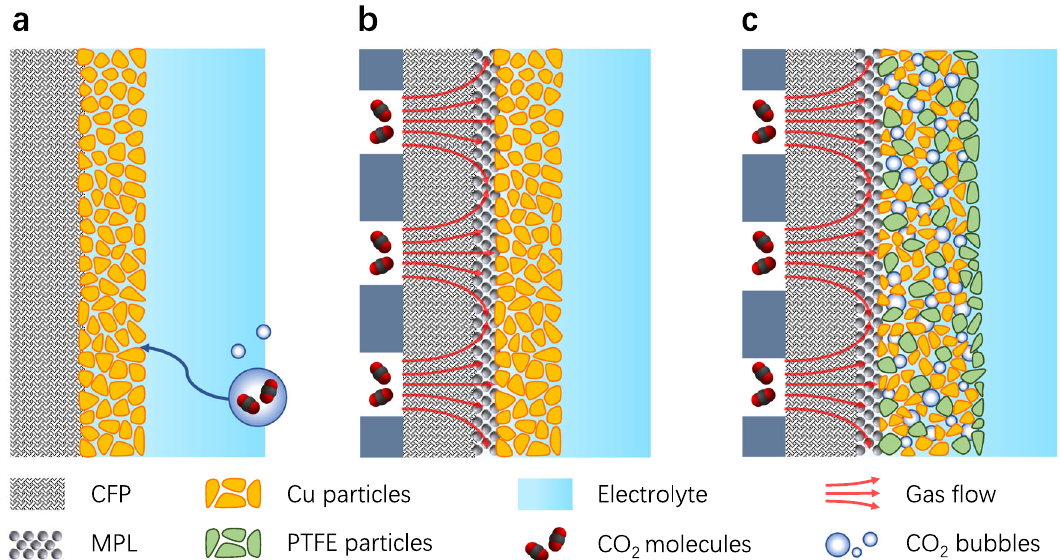
Fig. 1 Schematic illustration of different catalyst microenvironments and reaction interfaces. a Solid – liquid interface in an H-cell. b Solid – liquid interface in a regular GDE cell. c Proposed hydrophobic microenvironment with solid – liquid – gas interfaces that can be constructed in a GDE cell by dispersing PTFE nanoparticles inside the catalyst